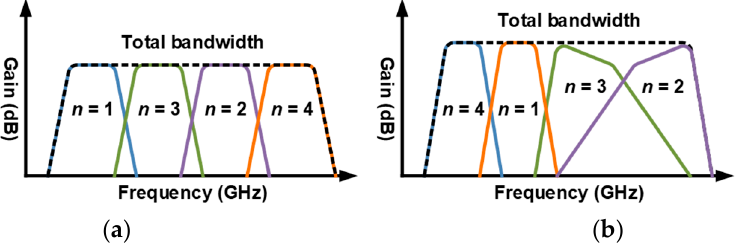
Figure 5. Strategies to secure wide bandwidth in multi-stage structures: ( a ) typical and ( b ) proposed techniques.